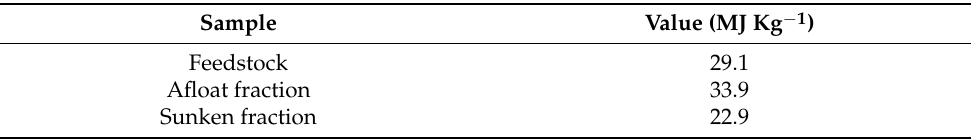
Figure 4. Van Krevelen diagram of the two fractions (afloat and sunken) and of the initial feedstock. The calorific values (HHV) of the initial feedstock and of the two fractions obtained from the separation in water are reported in Table 2. Table 2. Higher heating value (HHV) of the feedstock and of the two fractions obtained by density separation (afloat and sunken).